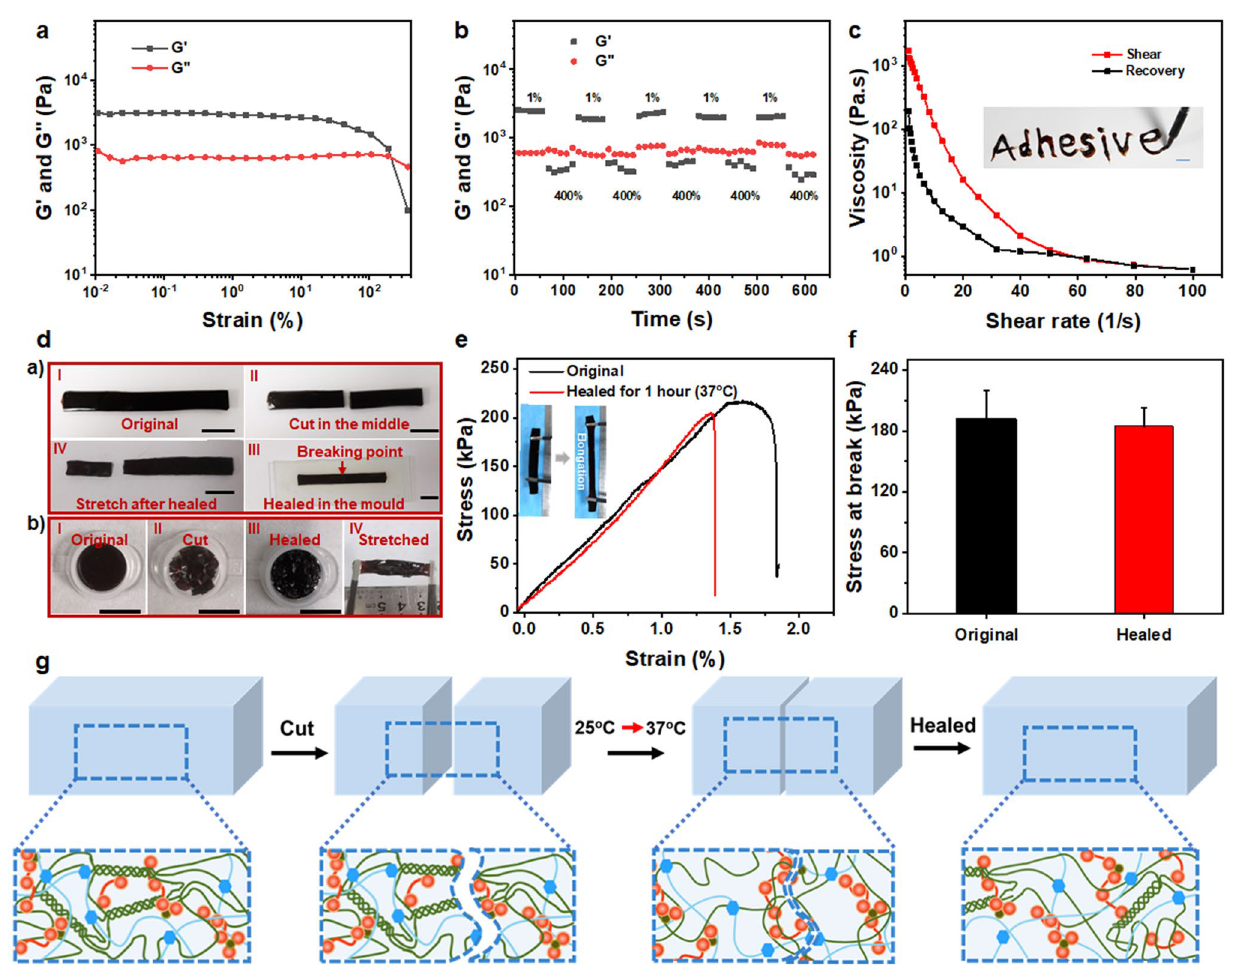
Fig. 3 Self-healing properties and injectability of the adhesive hydrogel GT-SA-TPF 20 . a Strain sweep of the hydrogel within the strain range of 0–500%. b Rheological self-healing properties of the hydrogel with strain switched from 1 to 400% for 5 cycles. c Shear rate-dependent viscos- ity of the hydrogel. Inset: image showing the injectability of the hydrogel. d Macroscopic self-healing display, a ) The original (I), fractured (II), healed (III) for 1 h and the secondary fractured (IV) state of the hydrogel, b ) The original (I), shattered (II), healed (III) for 3 h and stretched (IV) state of the hydrogel. e Stress–strain curves and f fracture stress of the original hydrogel and healed sample after cured for 1 h at 37 °C. Inset: images showing the tensile property of the hydrogel. g Illustration for the self-healing mechanism of the adhesive hydrogel. Scale bar: 1